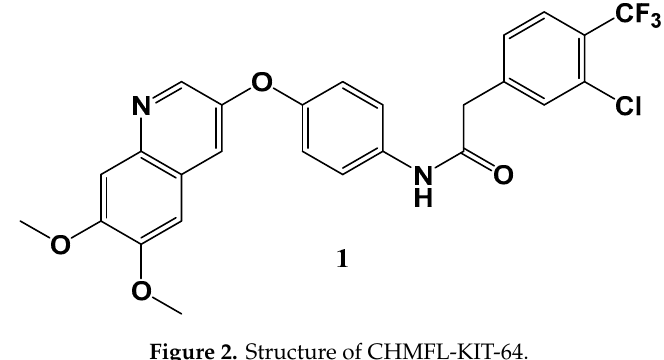
Figure 2. Structure of CHMFL-KIT-64.